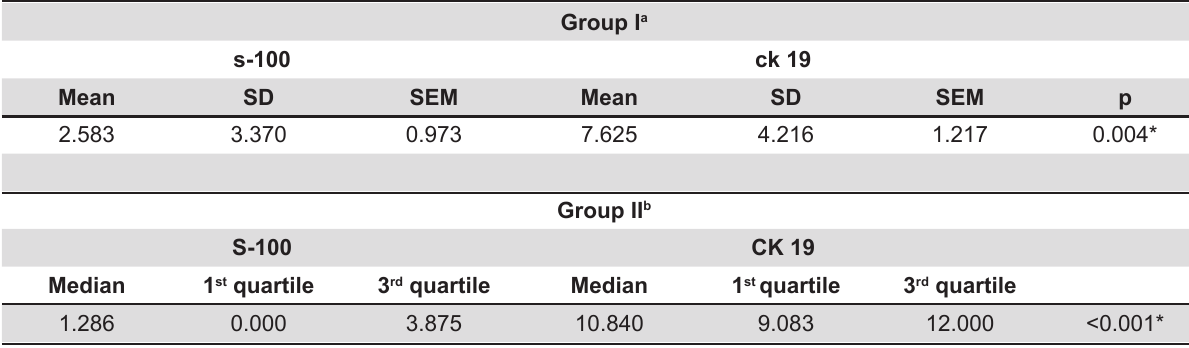
Table 2- Comparison between S-100 and CK 19 immunostaining of duct-like structures in groups I and II